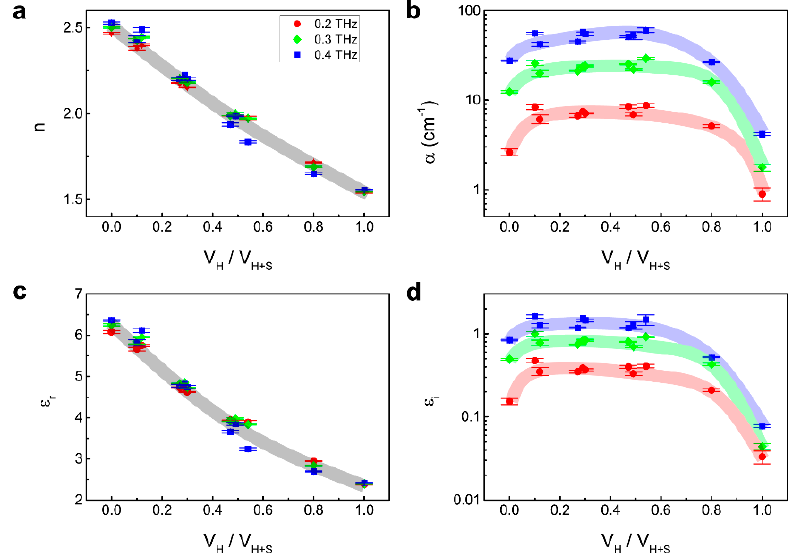
Figure 4. Optical indices as a function of volume ratio between HDPE and the entire mixture. ( a – d ) correspond to refractive index, absorption coefficient, the real and imaginary part of relative permittivity, respectively. Each line is a guide.